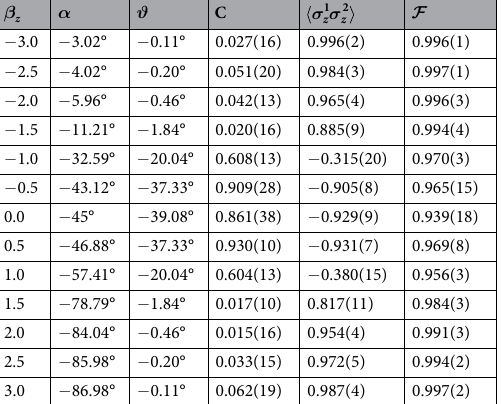
1 2 and fidelity of the simulated ground state compared to z z